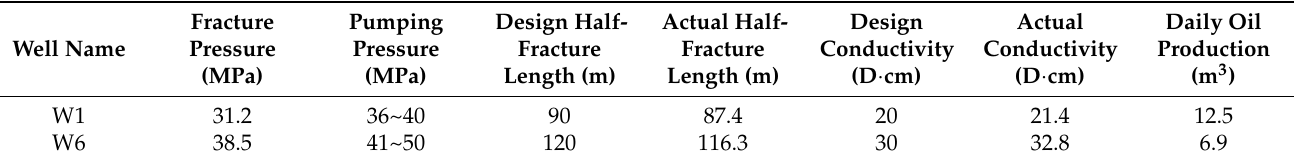
Table 5. Construction parameter comparison results.